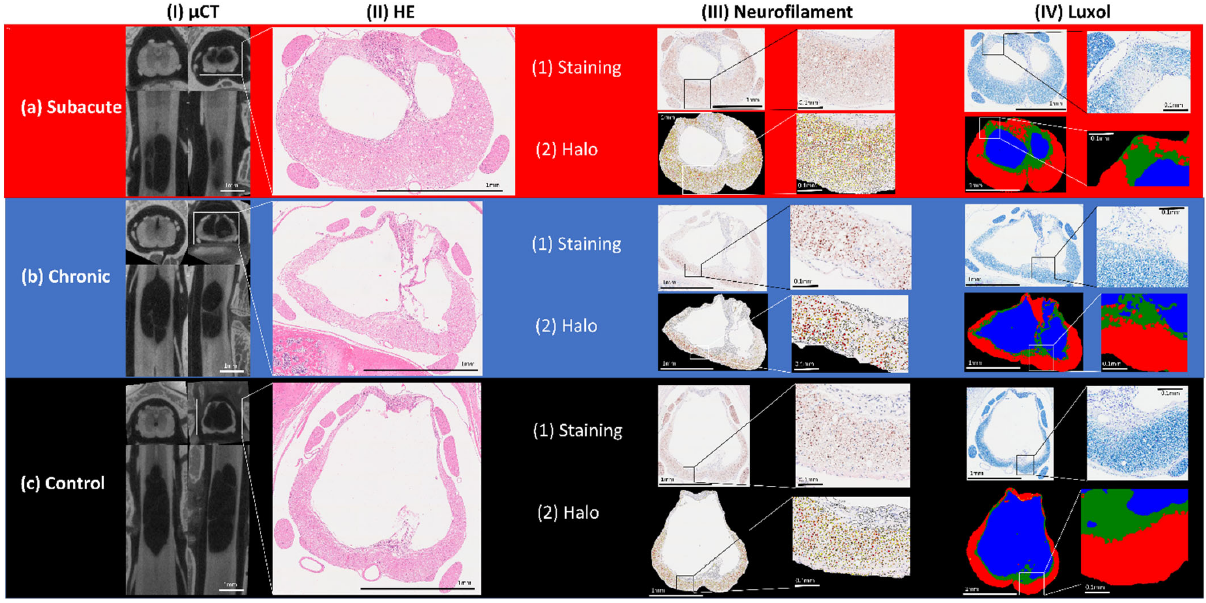
Figure 3. Morphological evaluation of injured spinal cords. ( a ) from left to right: two longitudinal sections of respective μ CT scans (cranial ( left ) and sagittal ( right ) plane) as well as cross ‐ sections of spinal cords rostral of the injury ( left ) as well as at the site of contusion ( right ). Representative spinal cords of groups ( a ) subacute ESWT (extracorporeal shockwave therapy), ( b ) chronic ESWT and ( c ) control: Corresponding subsequent HE staining (hematoxylin/eosin) of the injured area; ( a – c ) (1) NF ‐ staining (neurofilament) and Luxol staining of the same spinal cord slice and ( a – c ) (2) automated identification of NF ‐ positive and Luxol ‐ positive areas using Halo software. Far right: red area indicates myelinated tissue, green area indicates demyelinated tissue and blue indicates the cystic cavity.